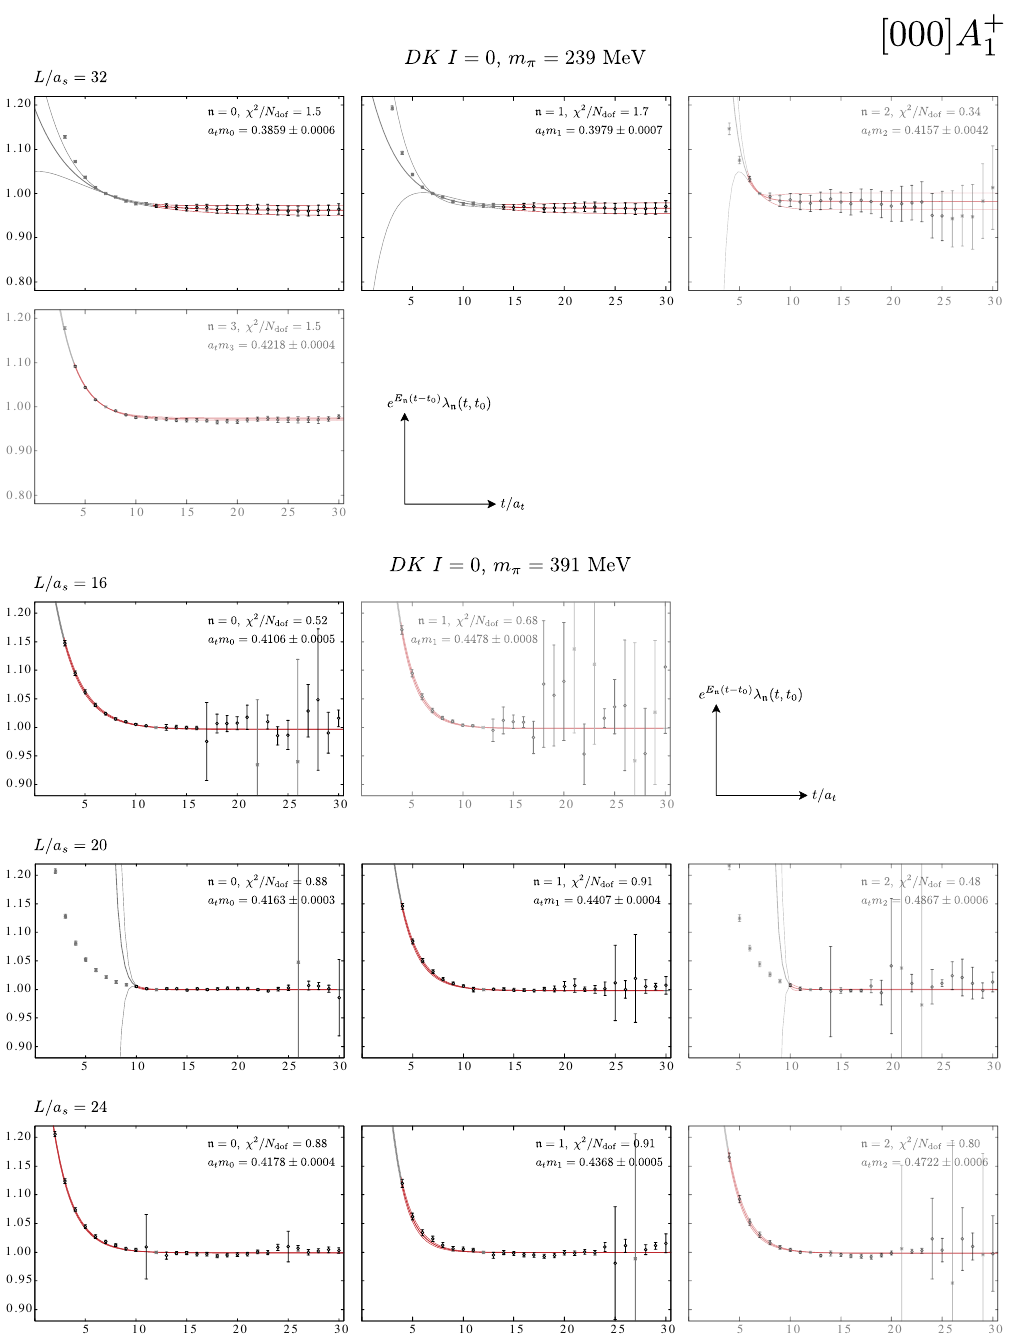
Figure 20 . The principal correlators, plotted as e E n ( t − t 0 ) λ n ( t, t 0 ) , obtained for DK I = 0 in the [000] A + irrep with m π = 239 MeV (top) and m π = 391 MeV (bottom). Points shown in grey were 1 not included in the fit. The red curves show the result of two-exponential fits as detailed in section 2 (this fit form enforces λ n ( t 0 , t 0 ) = 1 ). The mass extracted from the leading exponential and the χ 2 /N dof are indicated for each fit. These principal correlators correspond to the levels shown in figures 3 and 4; faded plots correspond to levels shown in grey in those figures and these are not used in the scattering